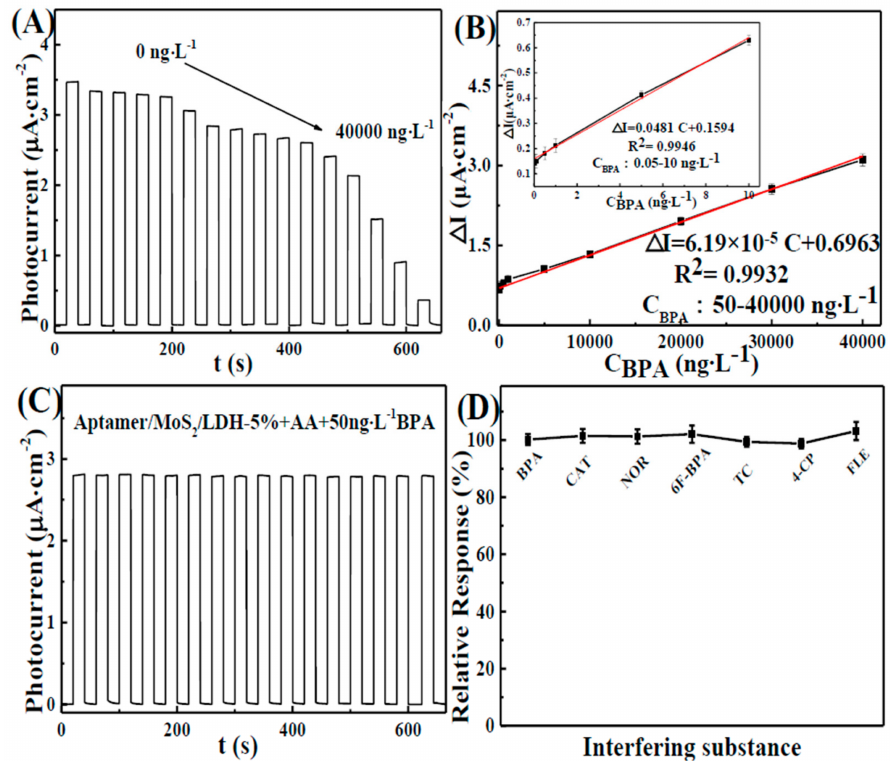
Figure 7. ( A ) Photocurrent responses of aptamer/MoS 2 /LDH-5% electrode toward BPA at increasing concentrations (0–40,000 ng L − 1 ). ( B ) Corresponding calibration plots of the BPA concentration. ( C ) Stable photocurrent response curve of the aptamer/MoS 2 /LDH-5% in the presence of 50 ng L − 1 PBA. ( D ) The photocurrent responses of 50 ng L − 1 BPA and interfering compounds, including 1000 ng L − 1 hexafluorobisphenol A (6F-BPA), catechol (CAT), tetracycline (TC), 4-chlorophenol (4-CP), norfloxacin (NOR) and fleroxacin (FLE) in 0.1 M PBS at 0.1 V vs. SCE with visible-light